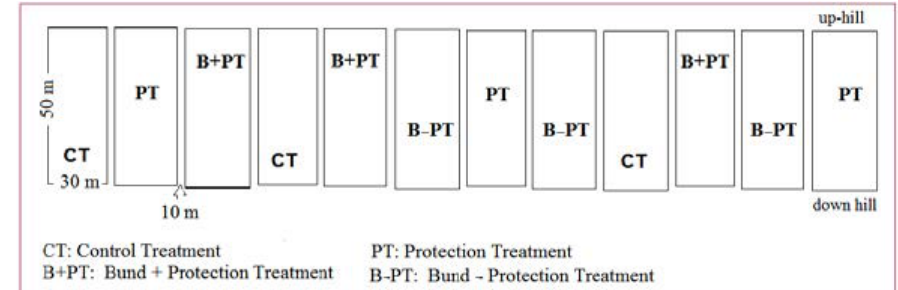
Fig. 2: Schematic diagram of experimental plot in the study area